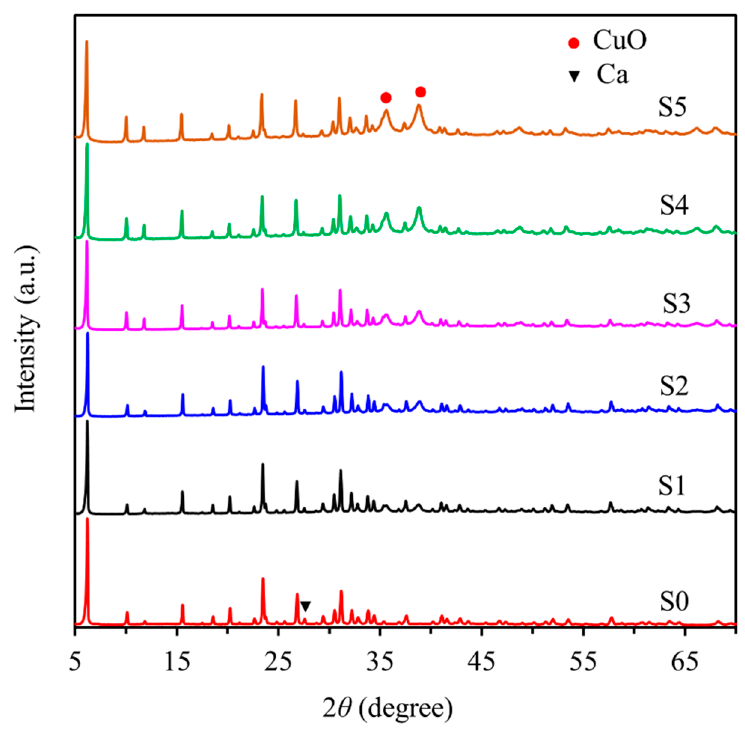
Figure 1. XRD patterns of samples: (S0) zeolite 10X; (S1–S5) CuO-zeolite NCs.